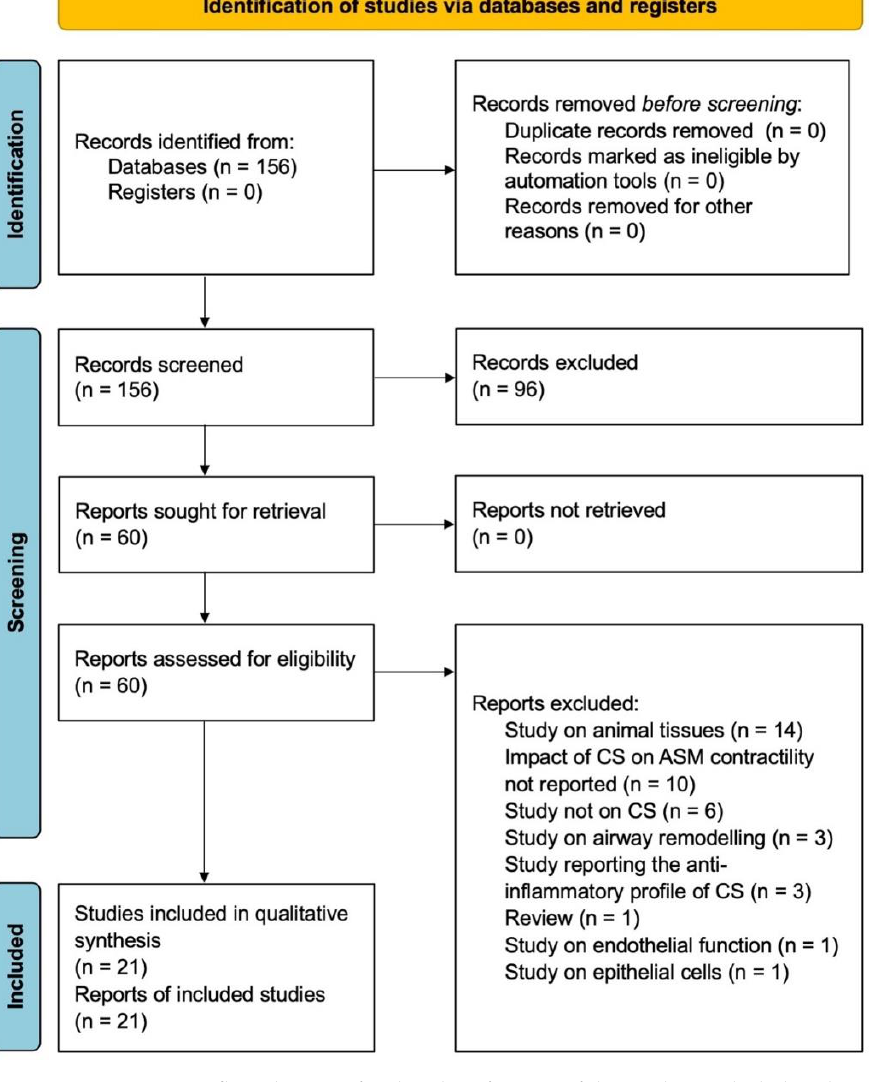
Figure 1. PRISMA 2020 flow diagram for the identification of the studies included in the systematic review. ASM: airway smooth muscle; CS: corticosteroid; and PRISMA: Preferred Reporting Items for Systematic Review and Meta-Analysis.